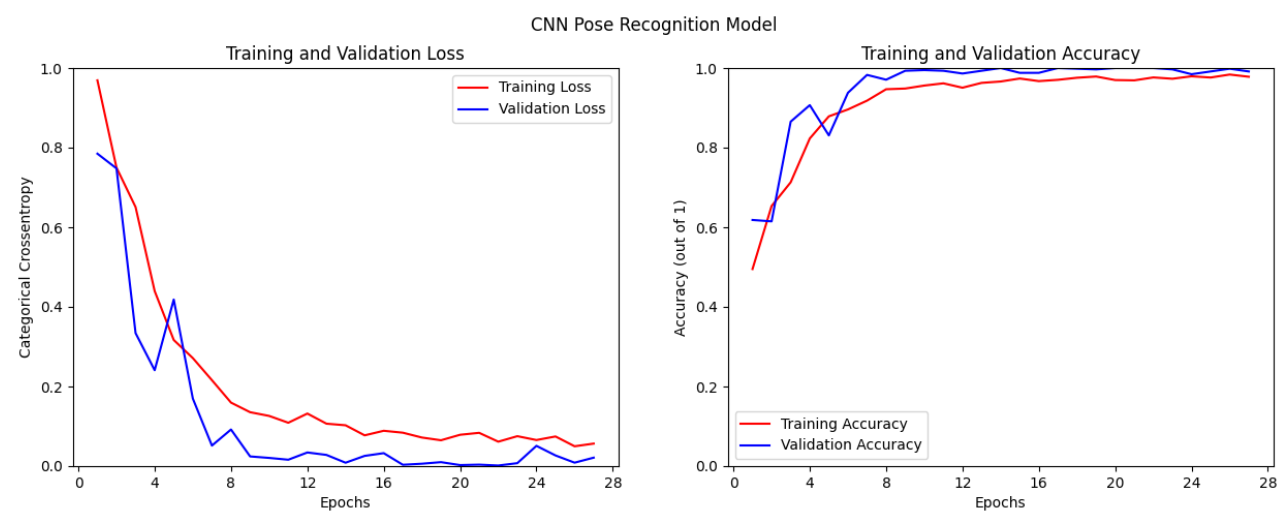
Figure 3. Graphs of the the CNN model’s training process. On the left , the categorical crossentropy values for the training and validation sets are plotted by epoch. On the right , training and validation accuracy (proportion of correctly predicted labels) are plotted by epoch.